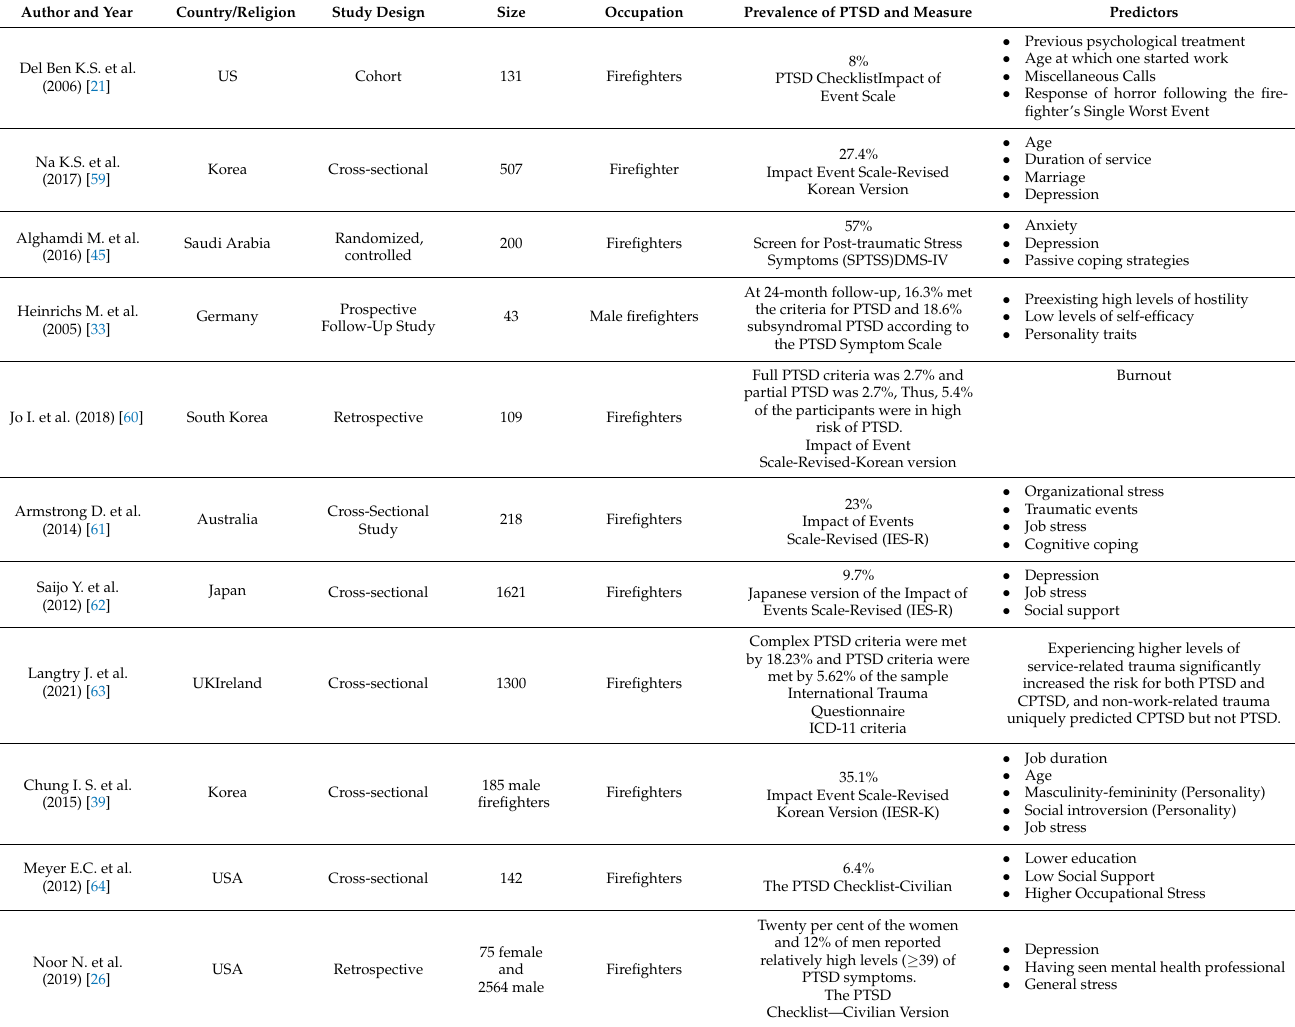
Table 2. Summary of studies with prevalence and predictors of PTSD among